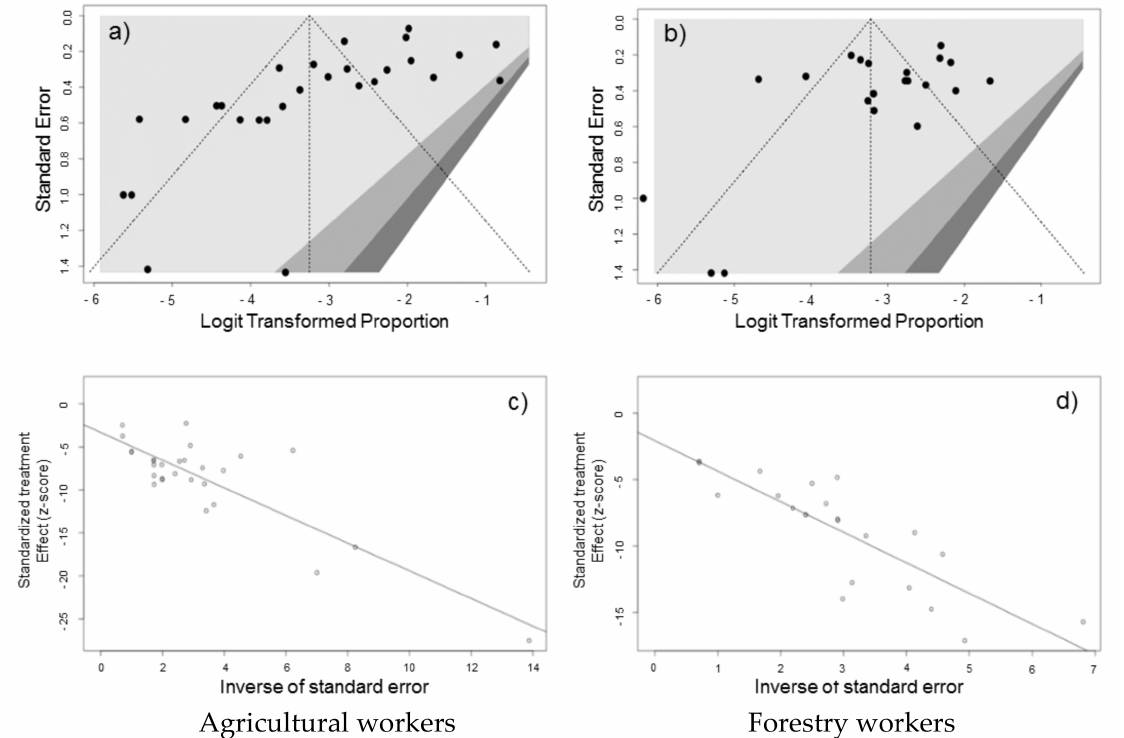
Figure 7. Border-enhanced funnel plots for studies included in the meta-analysis for agricultural workers ( a ) and forestry workers ( b ). Visual inspection of contour-enhanced funnel plots suggested substantial evidence of publication bias for both subgroups, but this was substantially rejected by Egger test for forest workers (i.e., t = − 1.81, df = 20, p -value = 0.0857) and confirmed for agricultural workers (t = − 3.92, df = 26, p -value = 0.0006 for forestry workers). On the other hand, in radial plots, the studies on agricultural workers ( c ) and forestry workers ( d ) were substantially scattered across the regression line, suggesting no significant small study